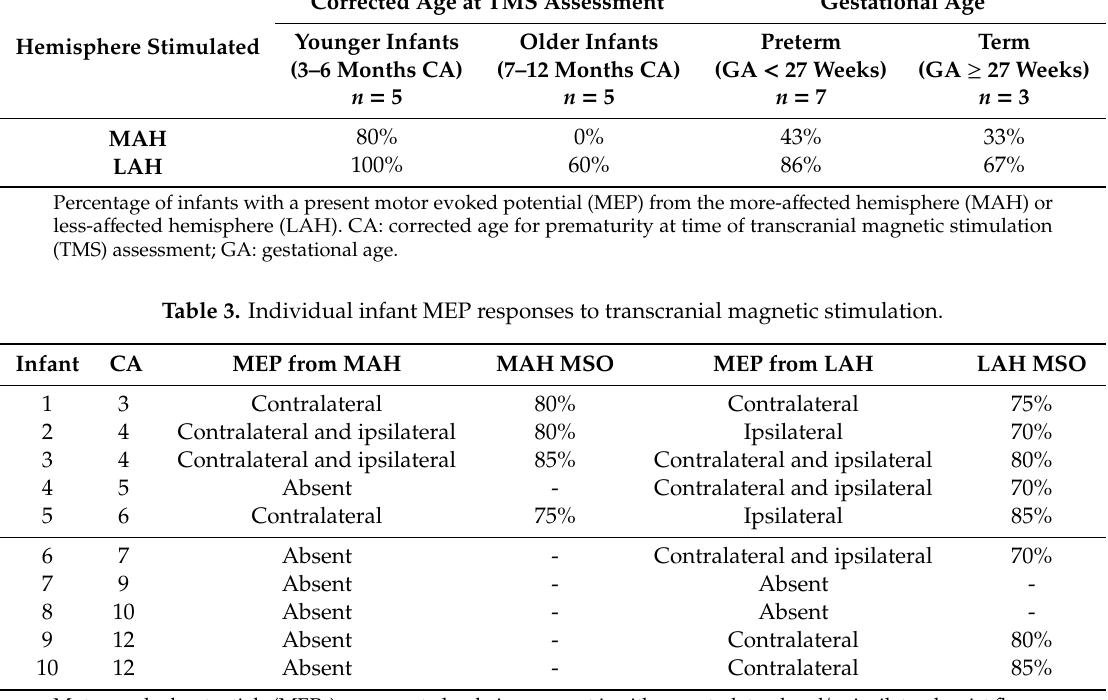
Motor evoked potentials (MEPs) are reported as being present in either contralateral and/or ipsilateral wrist flexors or absent. Maximum stimulator output (MSO) is reported as the lowest intensity at which an MEP was elicited from the more or less-affected hemispheres (MAH; LAH). Infants are ordered by corrected age (CA) youngest to oldest. Dotted line demarcates younger (infants 1 – 5) from older (infants 6 – 10) infant groups.